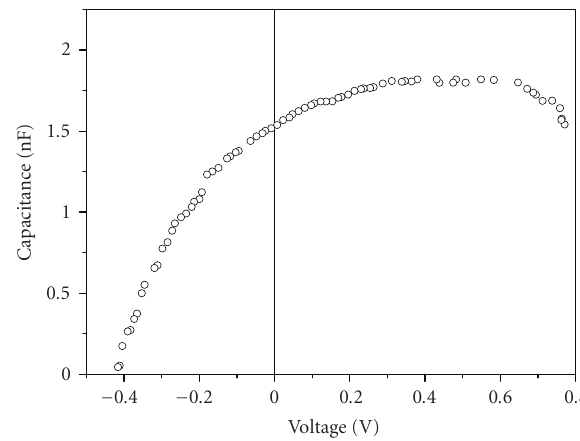
Figure 9: Capacitance-frequency characteristic of ITO/POT/Al structure.